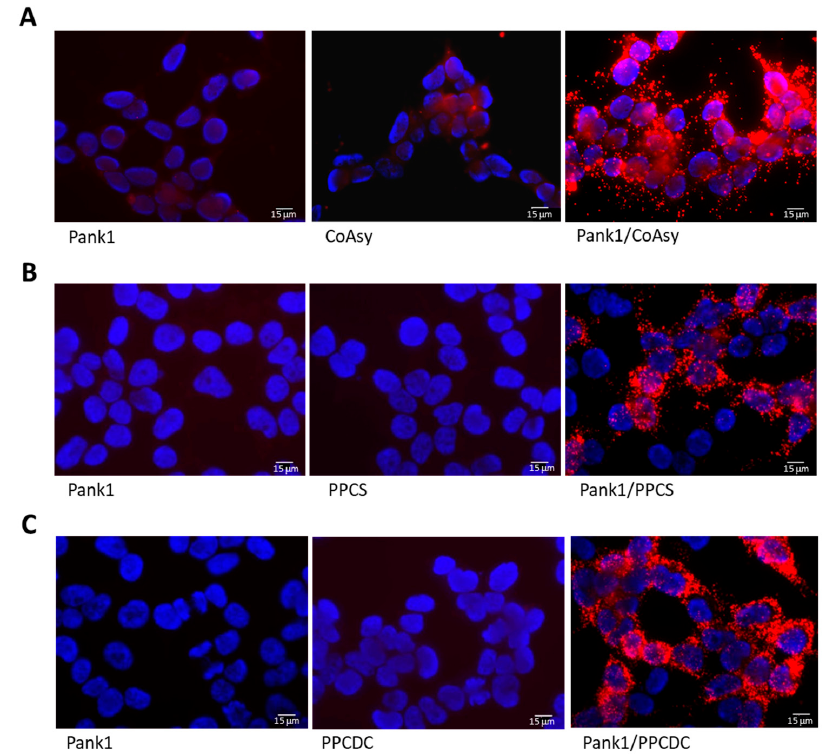
Figure 2. Validation of the proximity ligation assay (PLA) on HEK293/Pank1 β cells for the detection of proximity between Pank1 and other enzymes of the CoA biosynthetic pathway. The associations of Pank1 with CoAsy ( A ), PPCS ( B ) and PPCDC ( C ) are shown in exponentially growing HEK293/Pank1 β cells. Nuclei stained with DAPI (blue); PLA performed for Pank1 and other enzymes of the CoA biosynthesis (Red). Scale bars: 15 μ m. Data are representative of three independent experiments.